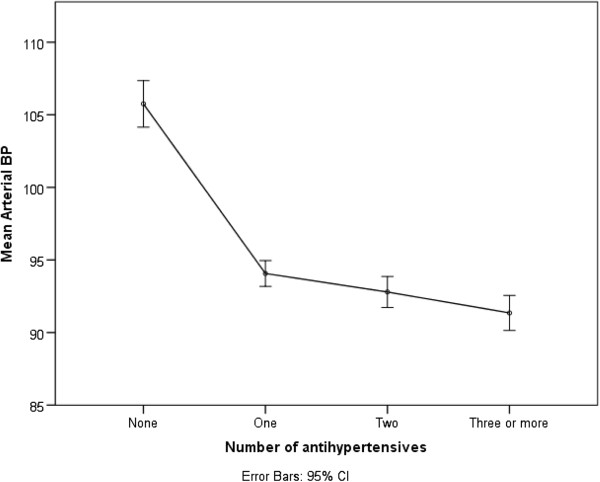
Number of antihypertensive medications and mean arterial BP in people with CKD 3 and hypertension.